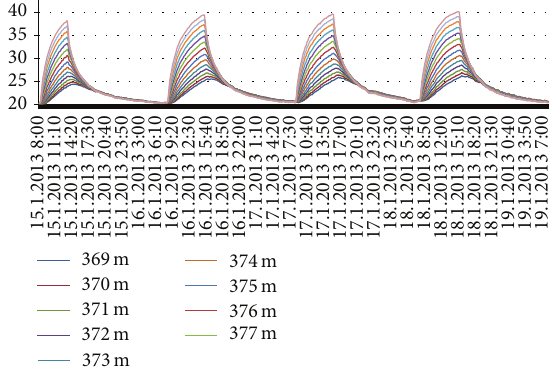
Figure 8: Heating-cooling cycles for asphalt.